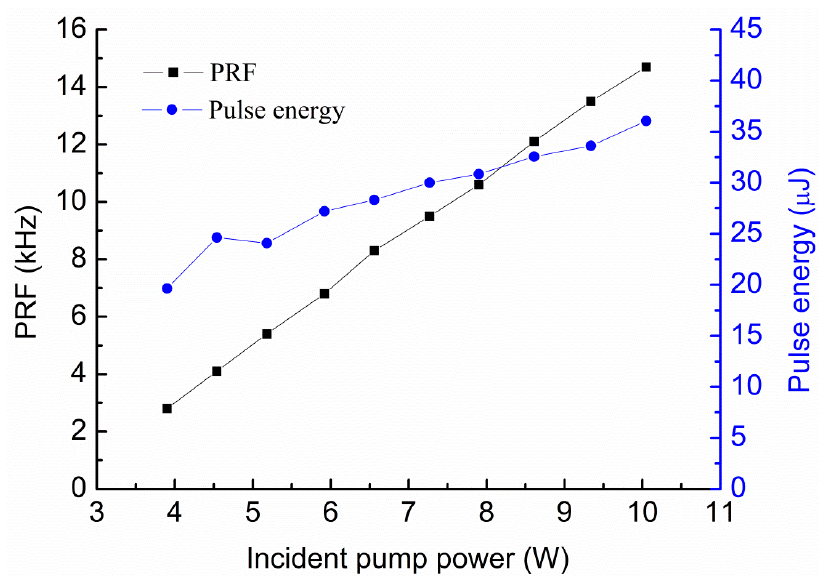
Figure 5. Pulse repetition frequency (PRF) and pulse energy versus incident pump power.